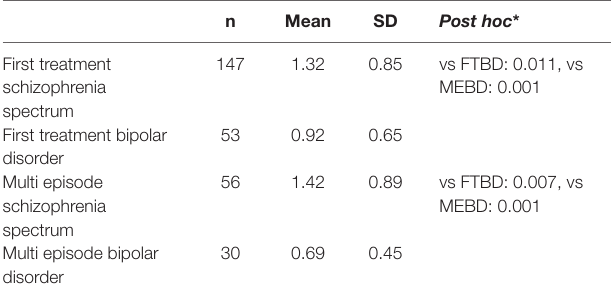
TABLE 3 | Total dosage of prescribed antipsychotics per defined daily dose (PDD/DDD) of all antipsychotics in use at baseline. N = 286 with information on PDD/DDD at baseline.